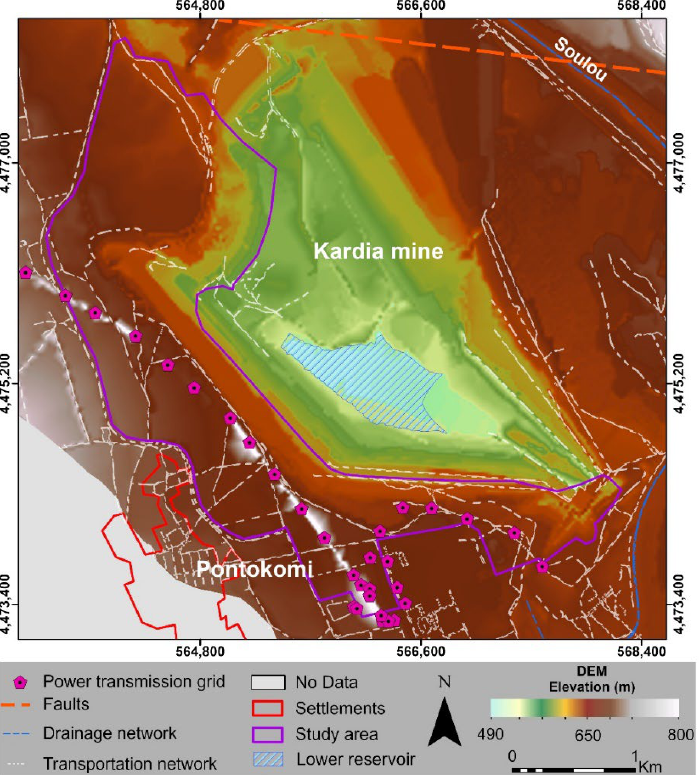
Figure 8. Map of Kardia mine illustrating the data inputs of geospatial analysis, e.g., the orange dashed lines depict the geologic faults, white lines present the transportation network, purple polygons show the power transmission grid, blue lines indicate the drainage network, the red polygons illustrate existing settlements, and the blue-dashed polygon area depicts the lower reservoir location.